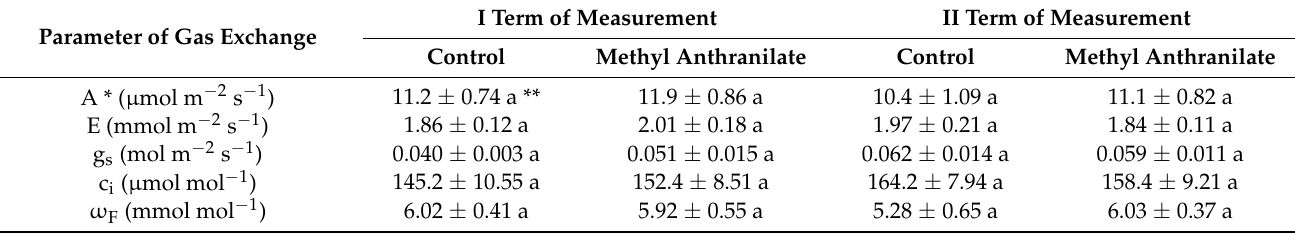
Table 5. The influence of methyl anthranilate on the parameters of gas exchange in the leaves of sweet cherry cv. ‘Burlat’. Parameter of Gas